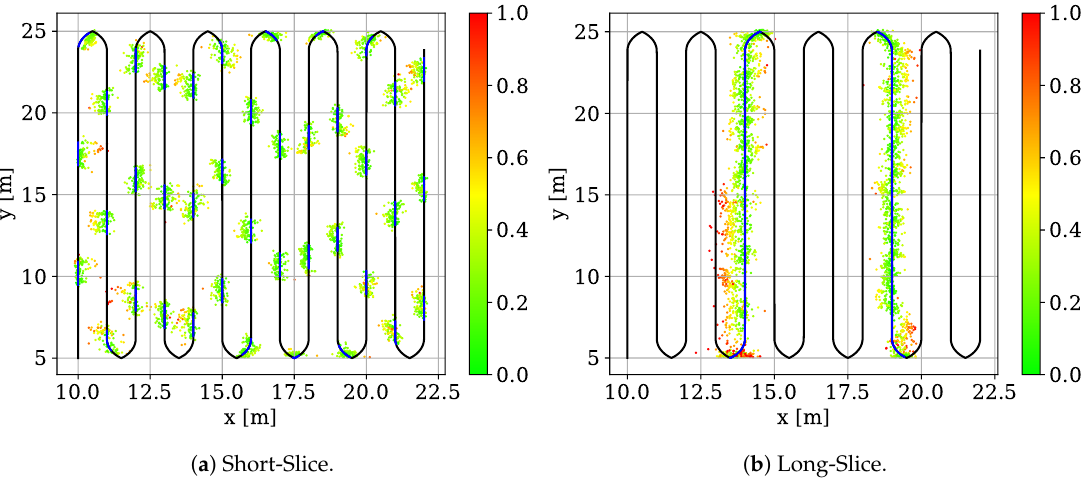
Figure 9. Evaluation of the model generalization [1].